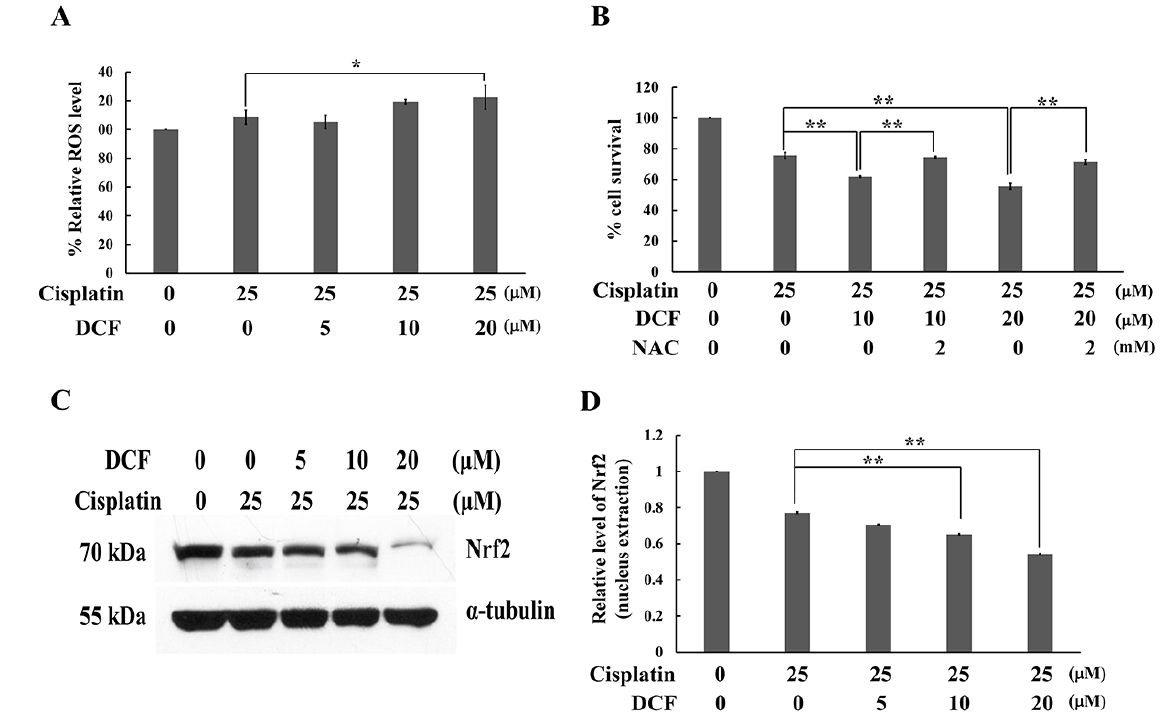
Figure 3. DCF potentiated the cisplatin cytotoxicity in KATO/DDP cells via the regeneration of intracellular ROS. ( A ) KATO/DDP cells were treated with either cisplatin alone or in combination with DCF and intracellular ROS was detected at 4 h after treatment by using DCF-DA dye, then the fluorescent intensity was determined. ( B ) KATO/DDP cells were treated with either cisplatin alone or in combination with DCF 10 or 20 µ M with or without NAC 2 mM and cell viability was assessed. ( C ) KATO/DDP cells were treated with either cisplatin alone or in combination with DCF 5, 10 or 20 µ M for 24 h, and the expression level of Nrf2 in the nucleus were detected by Western blot analysis. ( D ) Quantitative representation of band density for Nrf2 (nuclear extraction). Data were presented as mean ± SD. * Represented p < 0.05, while ** represented p < 0.01. DCF = Diclofenac, NAC = N-acetyl cysteine, ROS = Reactive oxygen